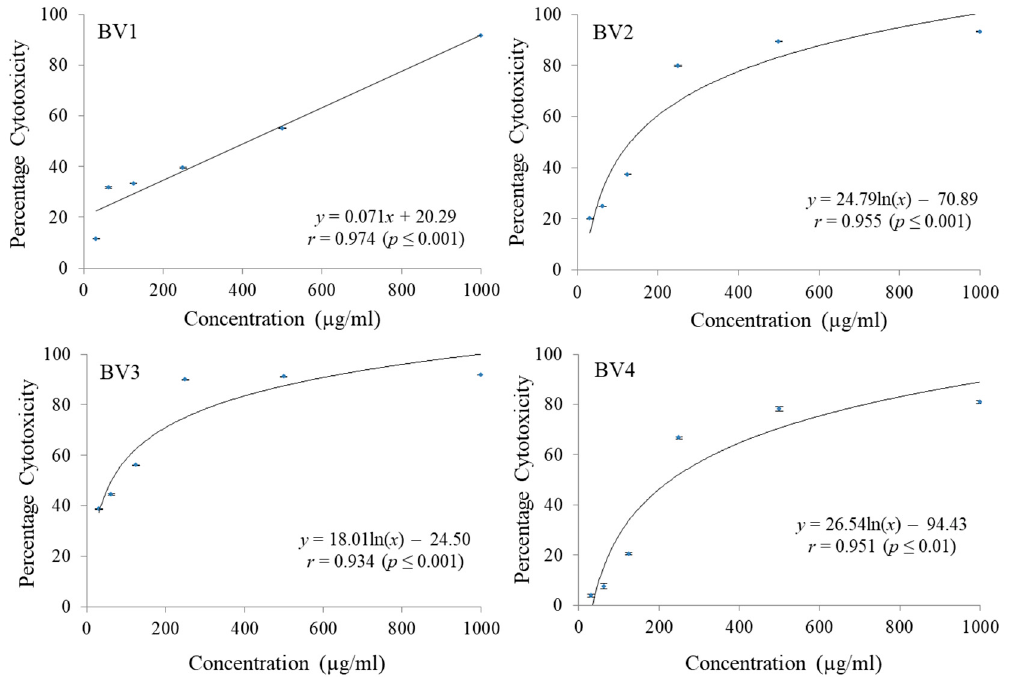
Figure 8. The percentage cytotoxic activity of compounds isolated from Bauhinia variegata L. bark against HCT-15 cell line. BV1 = kaempferol; BV2 = stigmasterol; BV3 = protocatechuic acid methyl ester; BV4 = protocatechuic acid